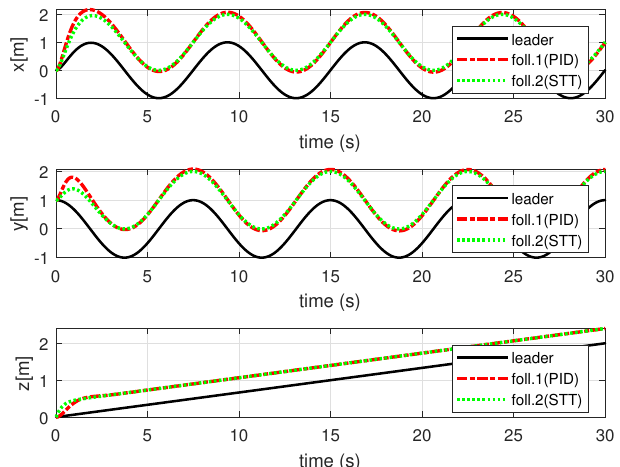
Figure 12. The results of the comparison simulation for the formation control of quadrotors about the 8 π circular trajectory: the red dashed line is the result of the formation control using the PID control method, and the green dashed line is the result of the formation control using the proposed formation control method with the state transformation technique (STT).